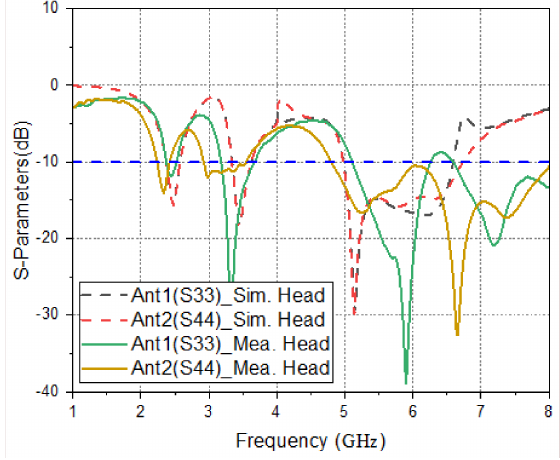
Figure 30. Simulated reflection coefficients of Ant. 3 and Ant. 4 in free space and when worn on the head.